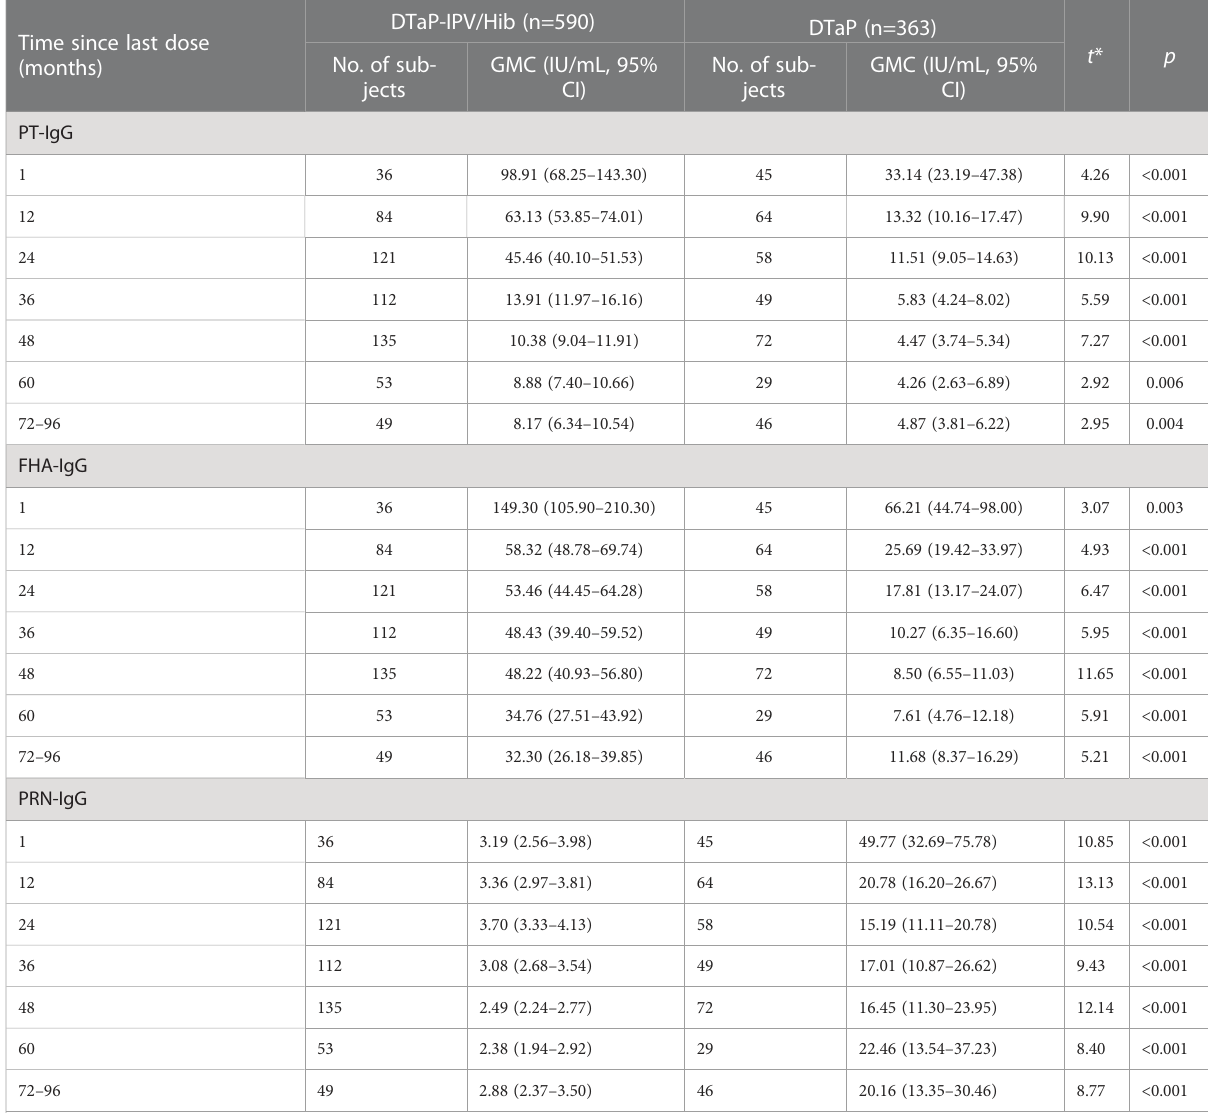
TABLE 3 The GMCs of pertussis IgG between the two groups.